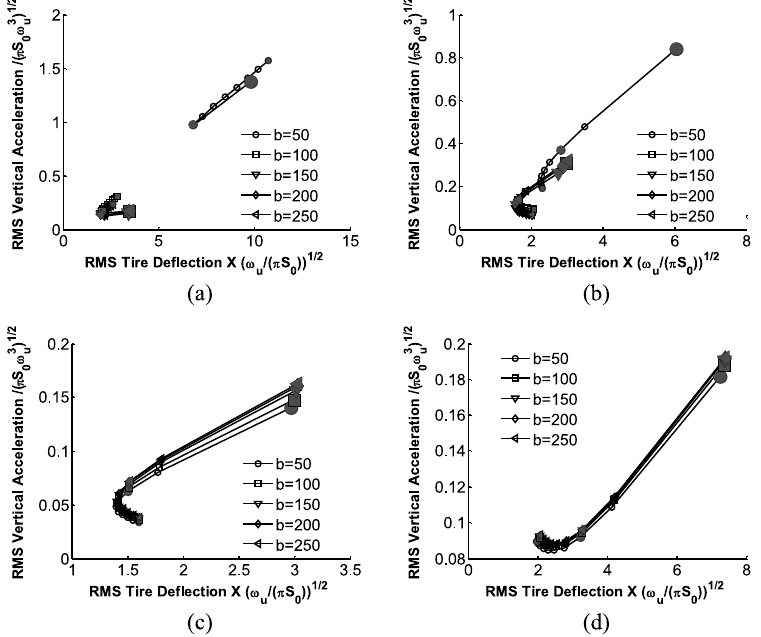
Fig. 7. Relationship between RMS acceleration and RMS tire de fl ection with layout s8 (effect of inertance and damping): (a) Passive; (b) Groundhook; (c) Hybrid; (d) Skyhook. The performance of the semi-active suspension with Layout s4 to Layout s10 under the Hybrid control is nearly the same. The performance is not very sensitive with the primary spring stiffness when the Layout s3 is